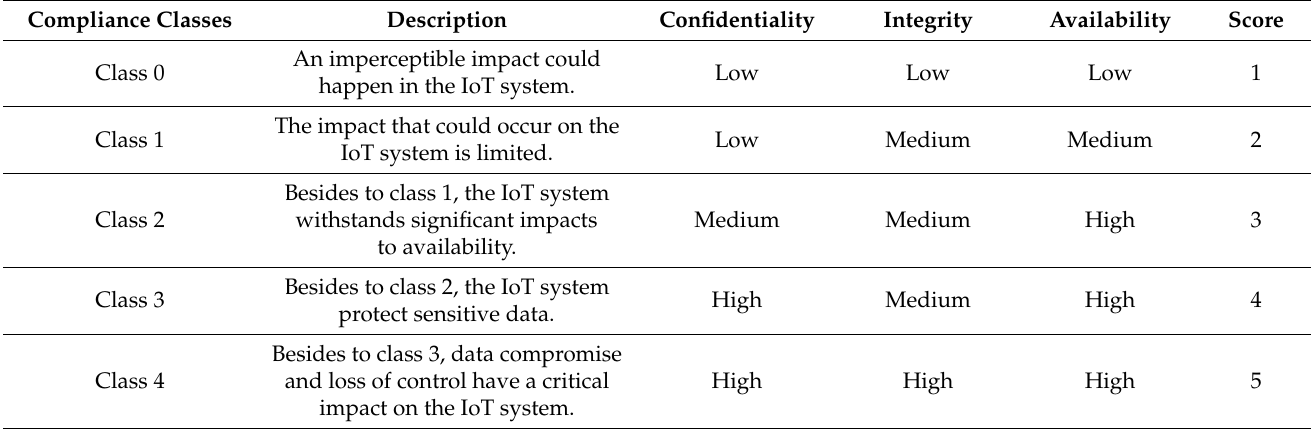
Table 6. Compliance class associated with confidentiality, integrity, and availability